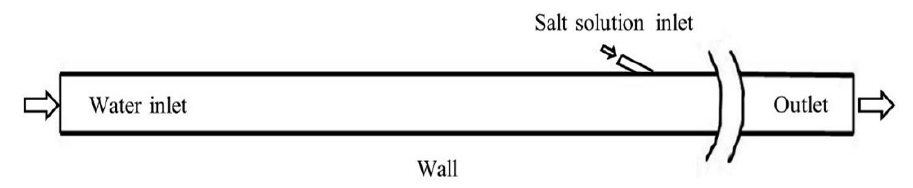
Figure 1. Computational domain in two dimensional views.